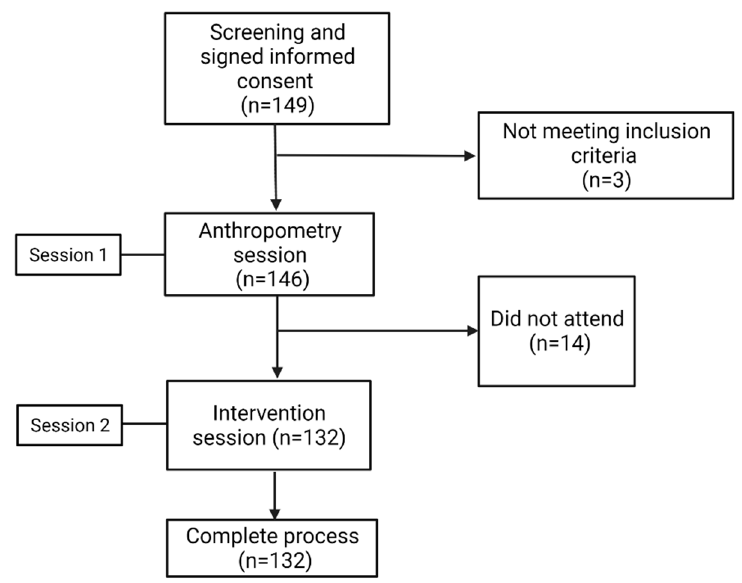
Figure 1. Flow diagram of subjects included in the study.